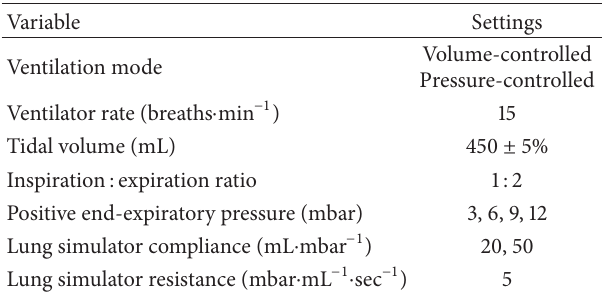
Table 2: Ventilator and lung simulator compliance